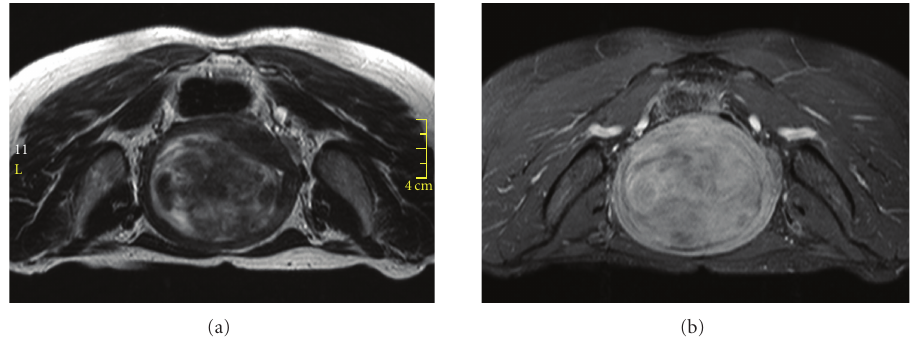
Figure 1: Patient screening MR images. (a) Axial T2-weighted image showing a heterogeneous fibroid, hyper intense relative to the uterine wall. (b) Contrast enhanced Axial T1-weighted screening MR image, showing enhancement of the